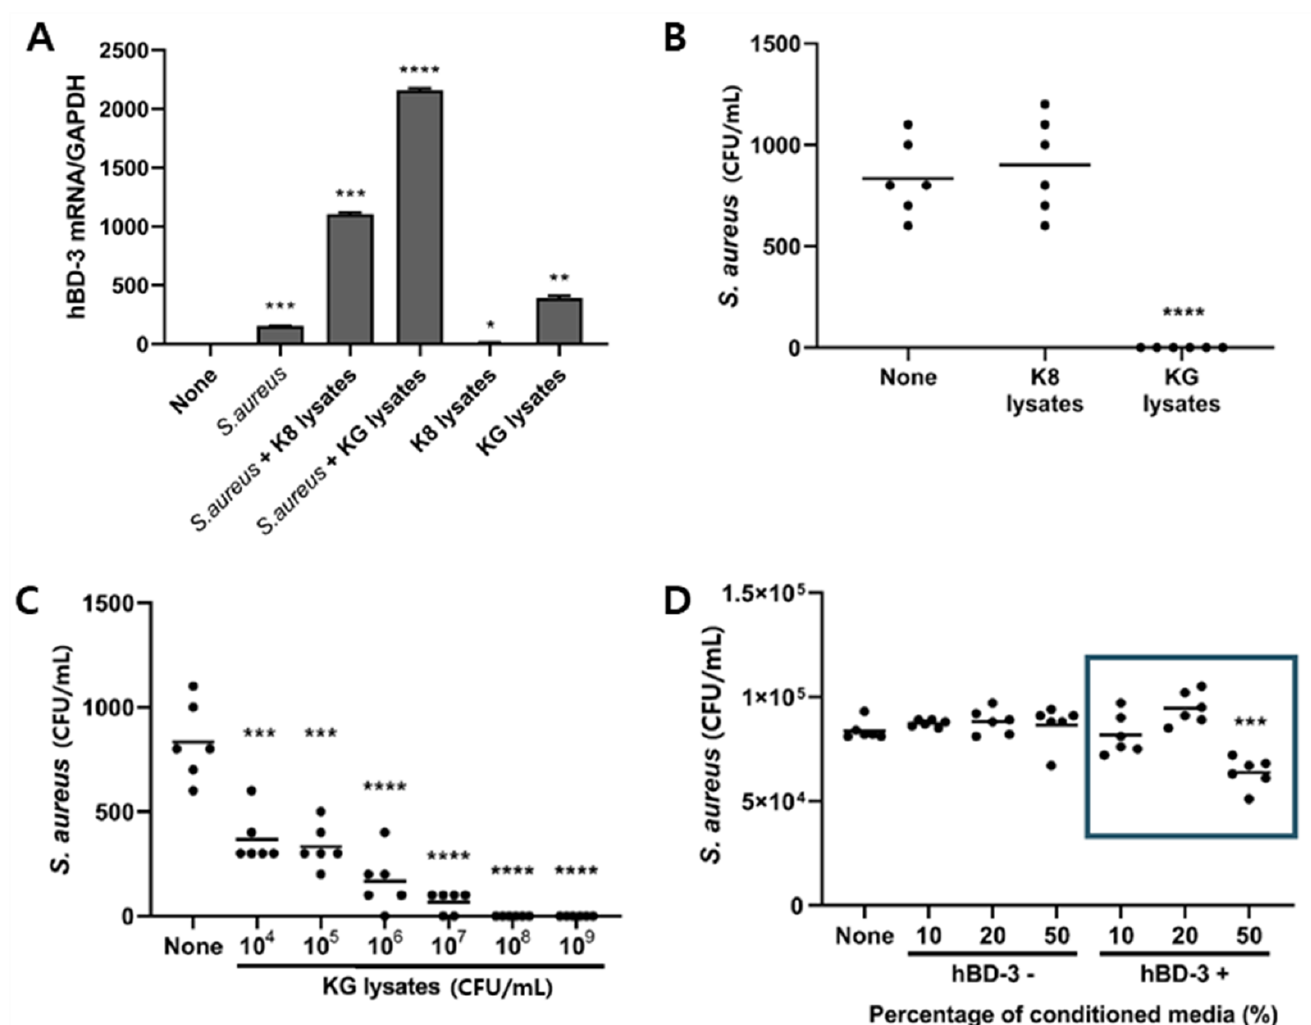
Figure 2. L. plantarum KG lysates inhibited S. aureus internalization by HaCaT cells. ( A , B ) HaCaT cells were treated with 1 × 10 9 cells/mL bacterial lysates for 72 h and infected with 1 × 10 6 cells/mL S. aureus for 6 h. After removal of extracellular S. aureus , cells were further incubated for 24 h. ( A ) hBD3 mRNA level was examined by real-time PCR. ( B ) Intracellular S. aureus was counted by spreading of cell lysates. ( C ) HaCaT cells were treated with the indicated dose of KG lysates for 72 h. After S. aureus infection (as described above), intracellular S. aureus was counted. ( D ) HaCaT cells were treated with hBD3+ and hBD3- CM for 72 h and the number of S. aureus was measured through the above method. *P<0.05, **p<0.01, ***p<0.001, and ****p<0.0001.